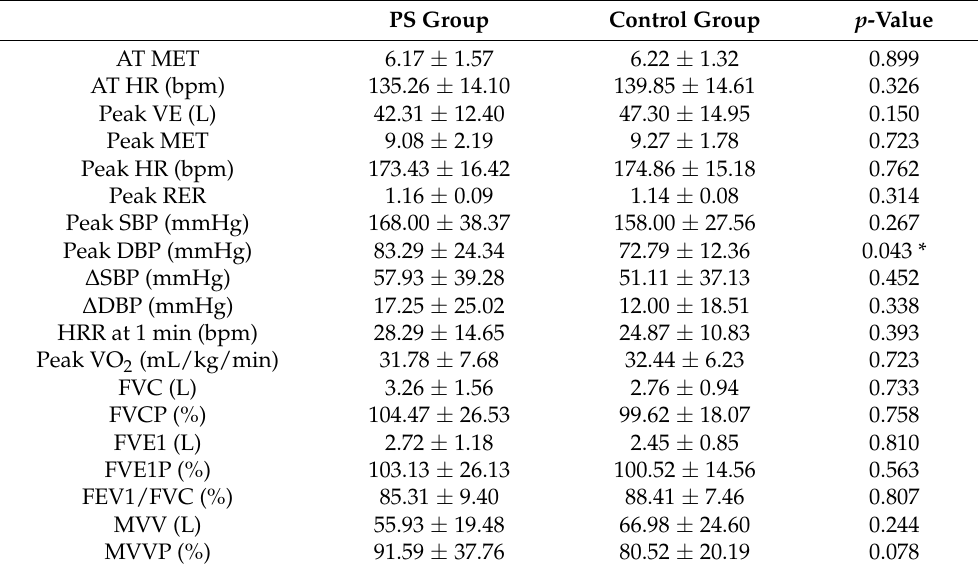
Table 3. Comparison of cardiopulmonary testing and pulmonary function testing in the first